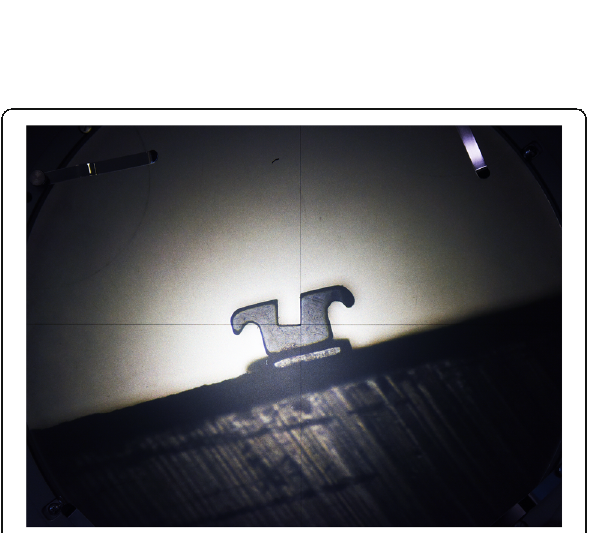
Fig. 2 Measurements of the brackets ’ slot with a profile